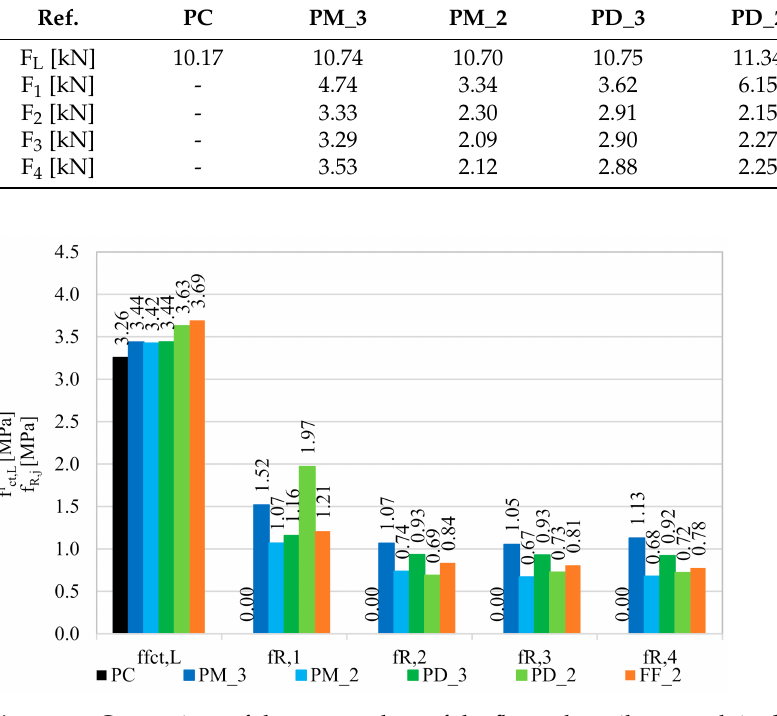
Figure 12. Comparison of the mean values of the flexural tensile strength in the range of limit of proportionality (f f ct,L ) and residual flexural tensile strengths (f R,j ) for the tested concrete